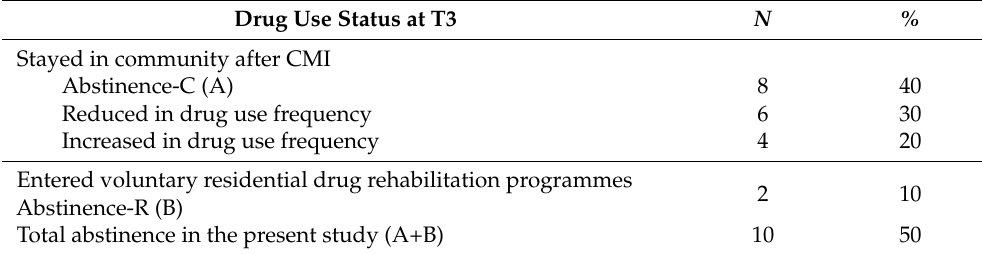
Table 2. Frequency table changes in drug use and abstinence at 3-month follow-up ( N = 20). Drug Use Status at T3 N %